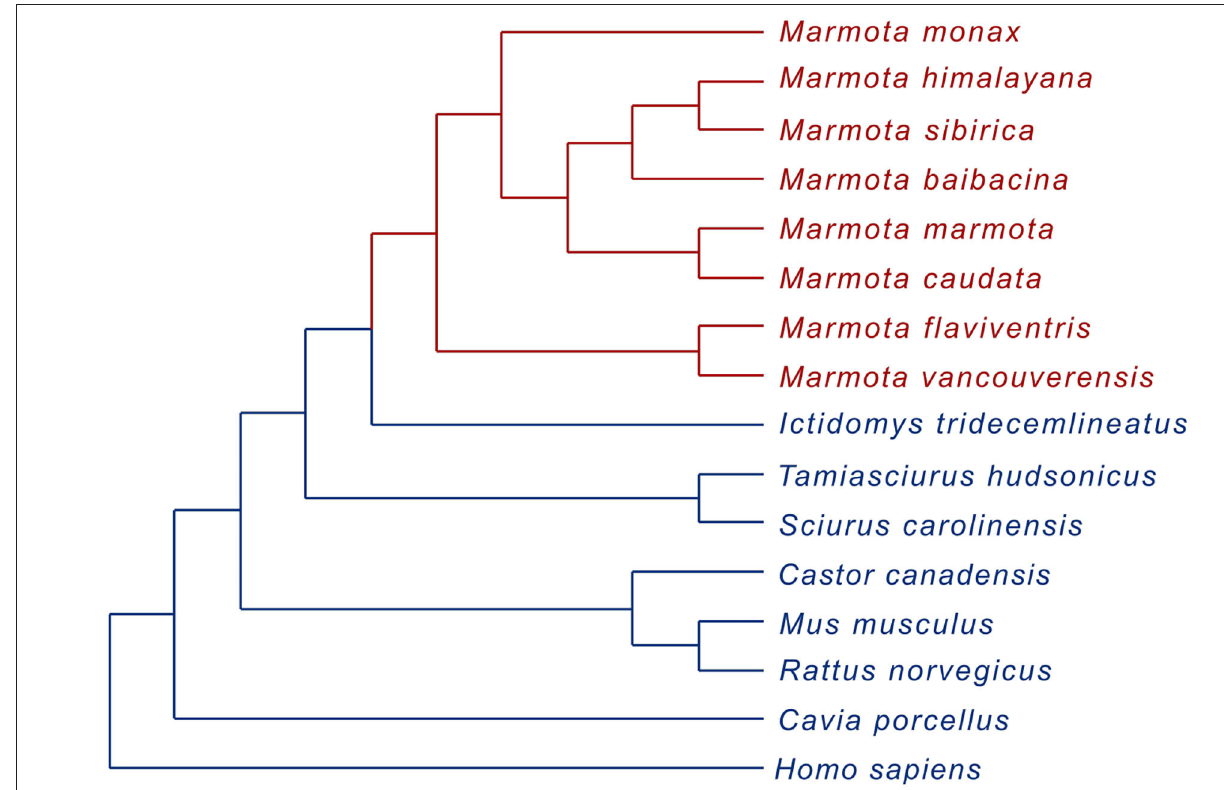
FIGURE 1 | A cladogram of the phylogenetic relationship of the species used for substitution rate analyses, divided into A: marmot clade (red) and B: other mammalian species (blue).